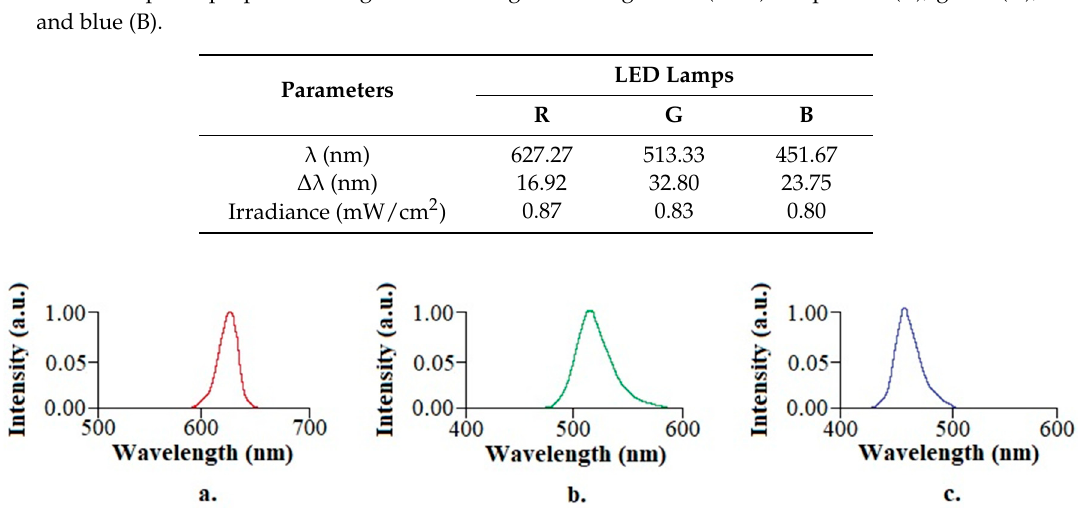
Figure 2. The spectral power distribution of the RGB LED lamps used in the study: ( a ) R LED lamp; ( b ) G LED lamp; and ( c ) B LED lamp.